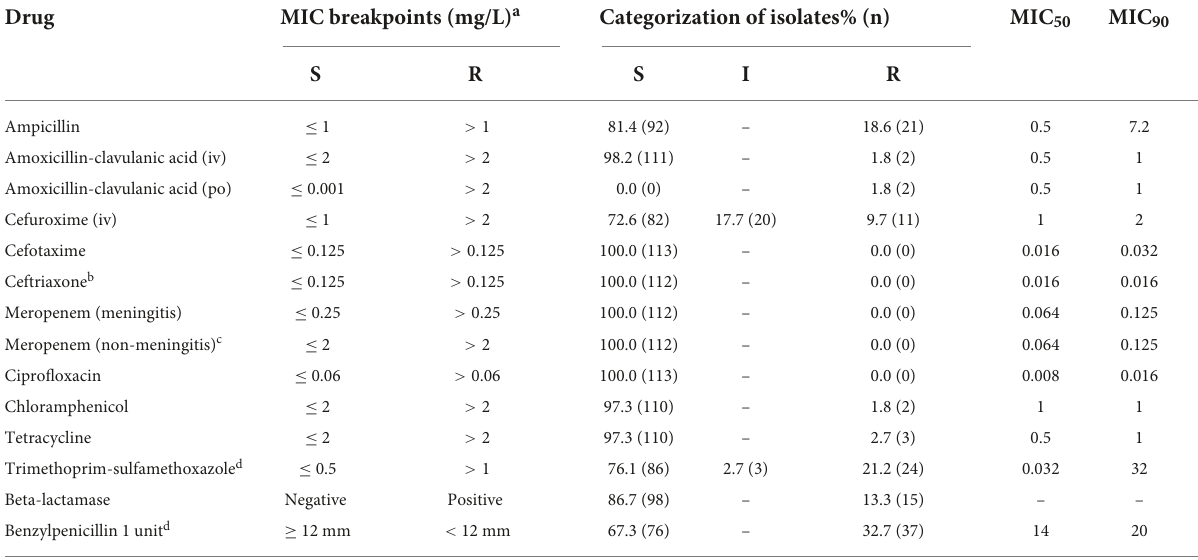
TABLE 4 Summary of antimicrobial susceptibility testing (AST) (gradient) of invasive Haemophilus influenzae isolates from Norway 2017–2021 ( N = 113). Drug MIC breakpoints (mg/L) a